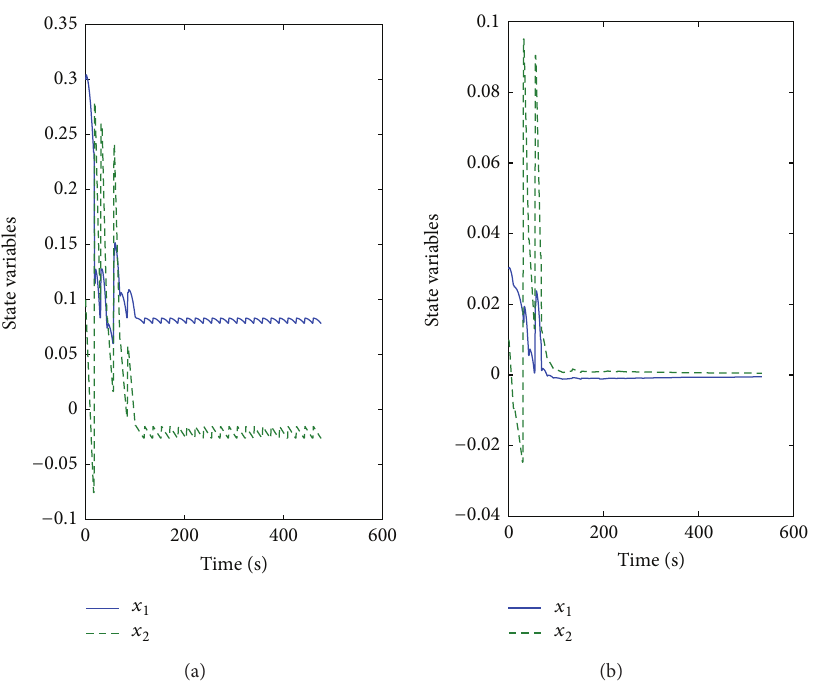
Figure 7: The state responses of the systems (a) (21) and (b)